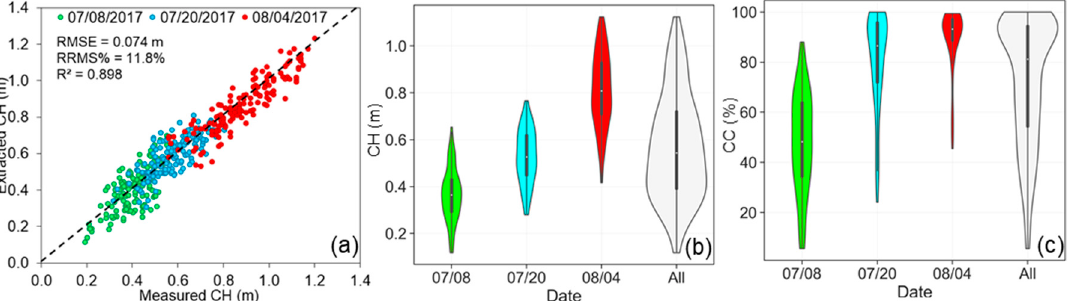
Figure 4. Comparison of measured and unmanned aerial vehicle (UAV) imagery-derived canopy height (CH) ( a ), CH distribution on 8 July, 20 July, and 4 August, and when combing CH data from those three dates ( b ); canopy cover (CC) distribution on 8 July, 20 July, and 4 August, and when combing CC data from those three dates ( c ). The violin plot demonstrates the maximum, minimum, median, first, and third quartile values of CH or CC, and the width of each violin element represents the frequency of CH or CC with the specific value. The distribution of CH and CC indicated a large spatial variety and heterogeneity of canopy structure in the vertical direction of soybean with almost closed canopy on August 4.